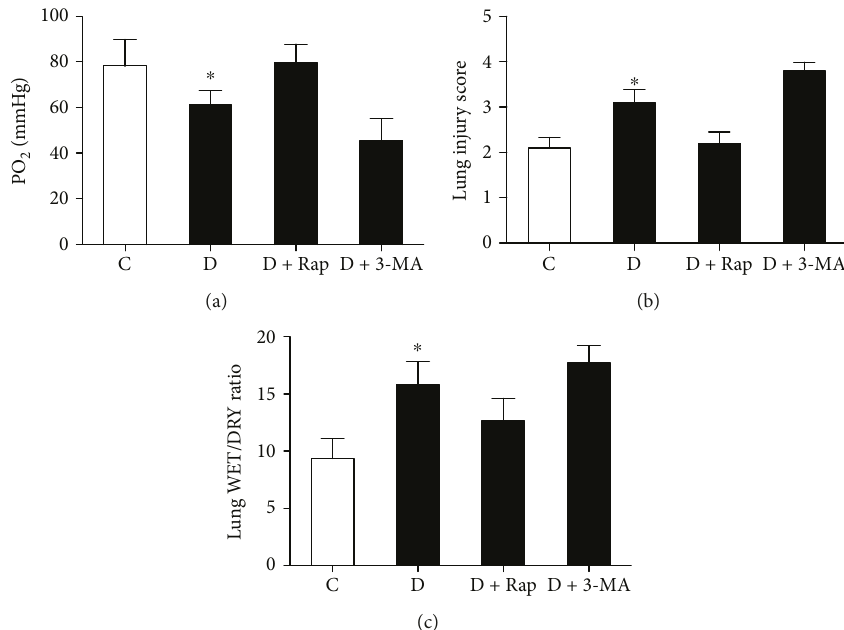
Figure 4: E ff ects of rapamycin (Rap) and 3-methyladenine (3-MA) on carotid blood partial pressure of oxygen (PO (b), and WET/DRY ratio (c) in control and diabetic rats undergoing myocardial ischemia reperfusion (IR). All values are expressed as means ± S.D., n = 8 . ∗ P < 0 05 versus the other